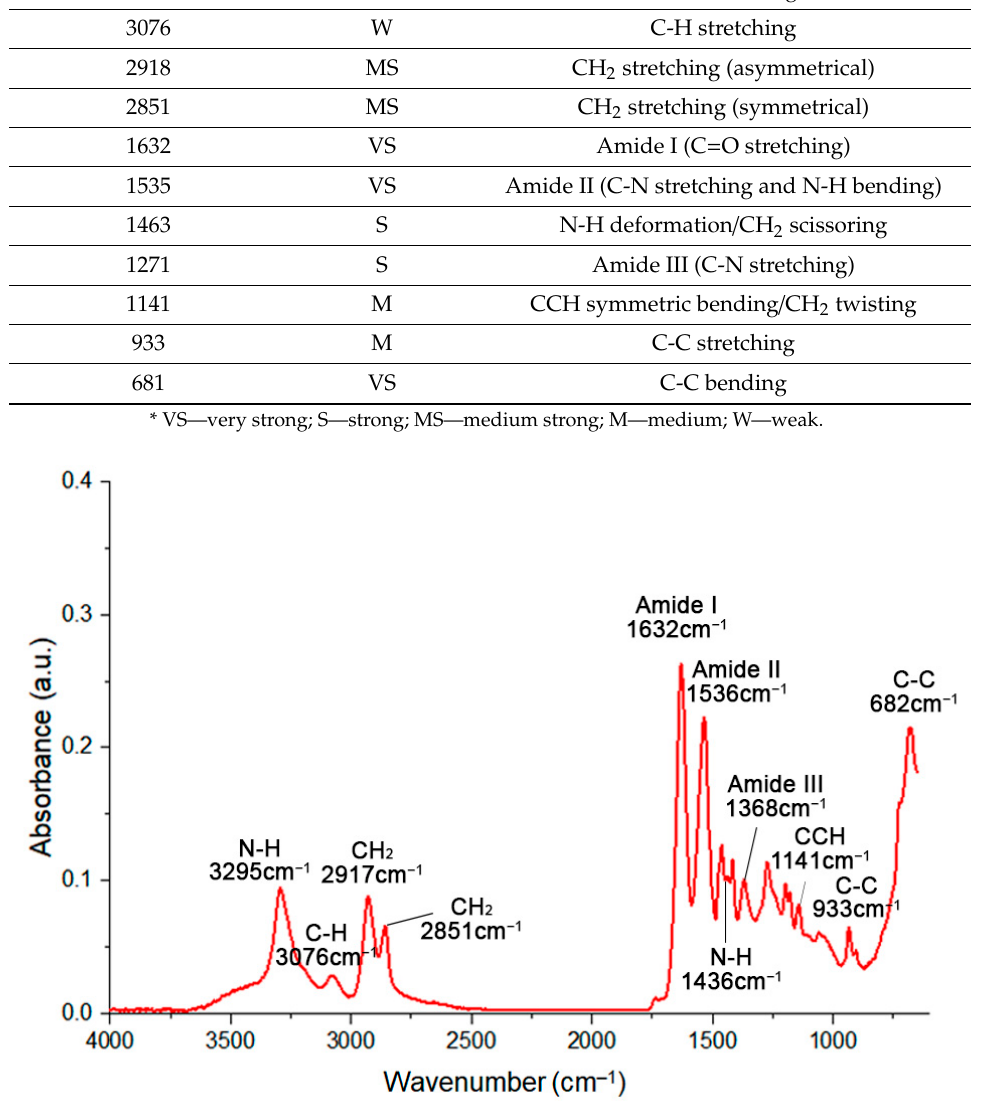
Figure 12. FTIR spectra of PA66 microfibres before (blank) and after the treatment (SP1-SP6) with different conditions of UV and TiO 2 . SP1 = deionised water; SP2 = deionised water + TiO 2 ; SP3 = deionised water + UVA; SP4 = deionised water+UVA+TiO 2 ; SP5 = deionised water + UVC; SP6 = deionised water + UVC + TiO 2 . a.u—arbitrary units.